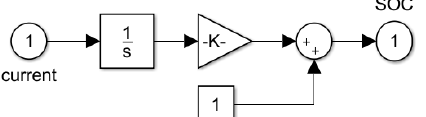
Figure 6. Simulink Model Verification Structural Diagram. Figure 7. The internal structure of ampere-hour ( AH) integral.